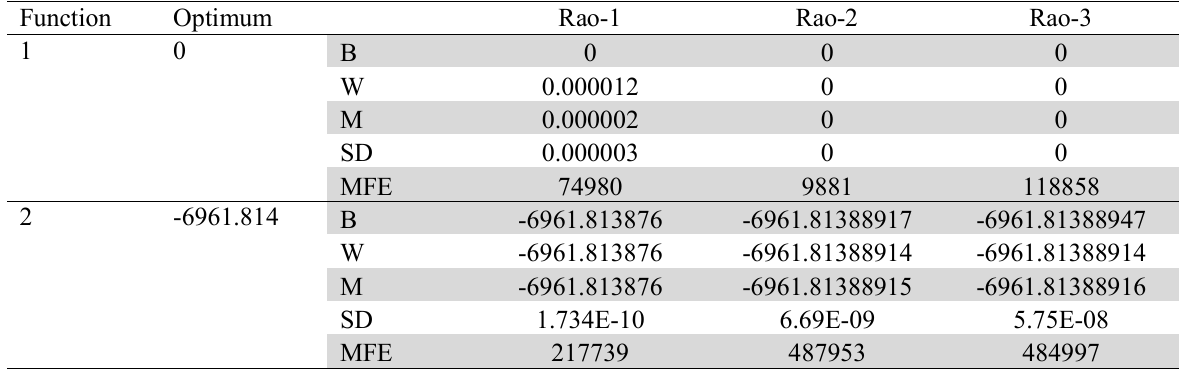
Results of constrained benchmark functions